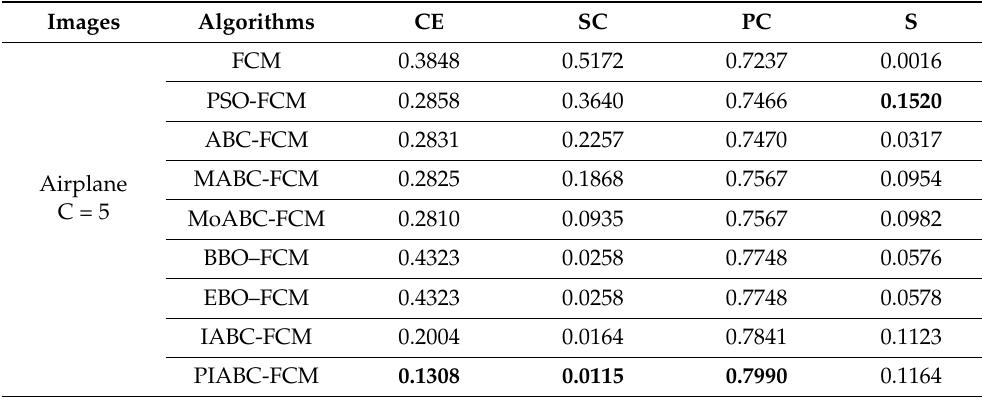
Table 6. Outcomes of PIABC-FCM and other clustering algorithms on airplane image.